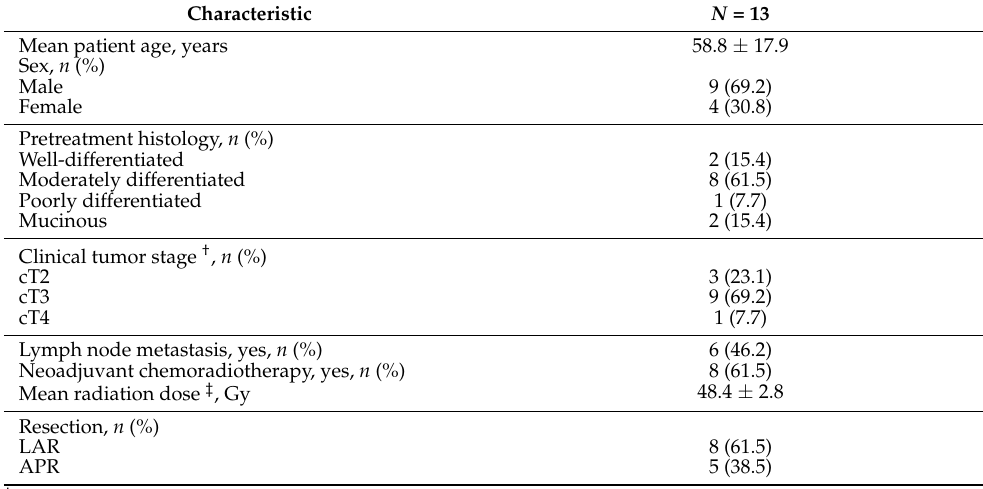
Table 1. Clinicopathological characteristics of patients with locally advanced rectal